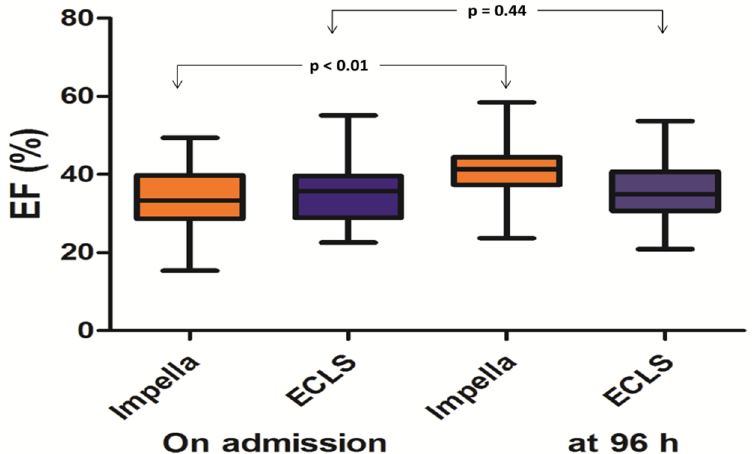
Figure 3. Systolic left ventricular ejection fraction on admission and at 96 h among Impella and ECLS patients demonstrating a greater functional recovery among the Impella patients.